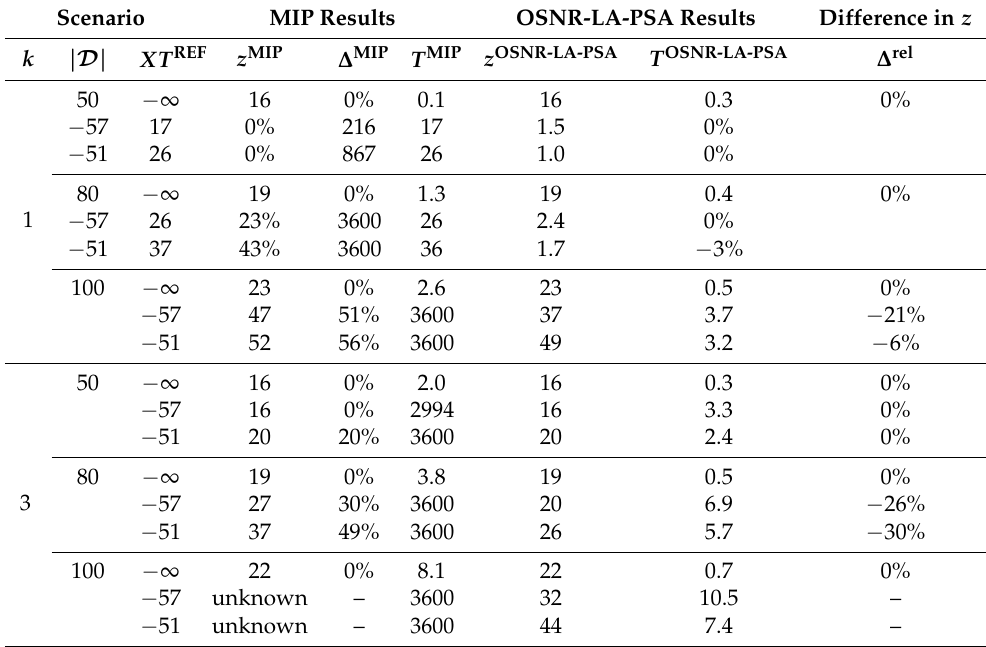
Table 6. Comparison of MIP and OSNR-LA-PSA performance in different routing, traffic and crosstalk scenarios in network DT12; T MIP and T OSNR-LA-PSA in